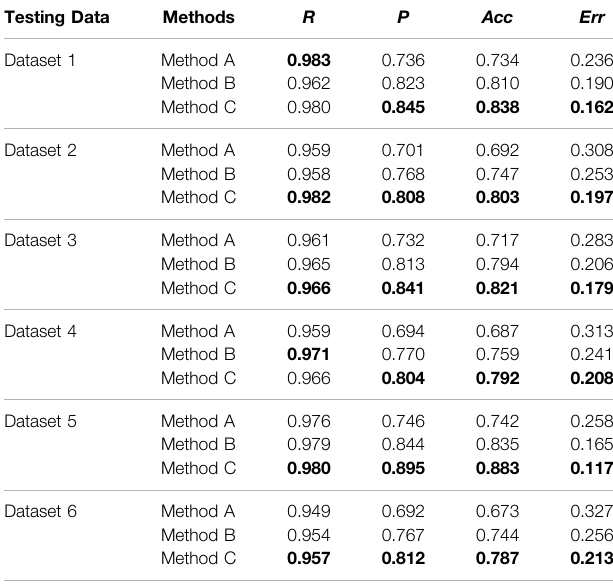
TABLE 4 | Detection Performance Comparison between the Three Methods in case 2. The bold values mean the best detection performance among the three detection methods (Method A, Method B, and Method